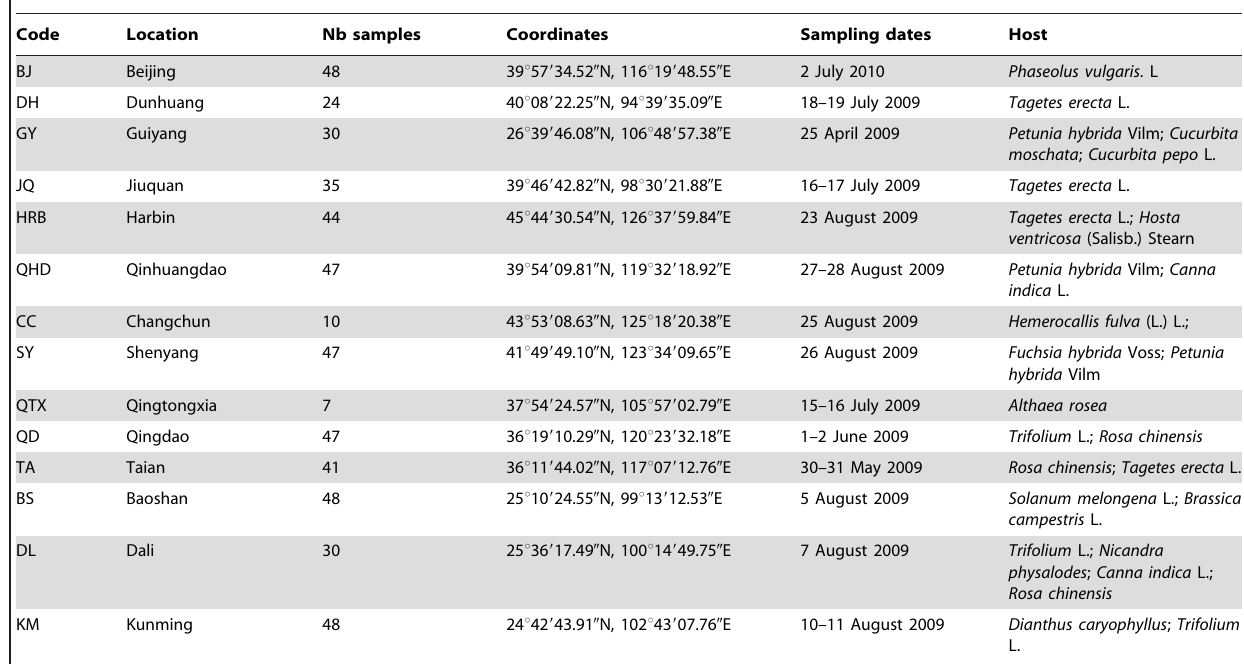
Nb samples, number of samples. ( H S ). We used the one-side group comparisons in FSTAT with 1000 permutations to test for significant differences in allelic